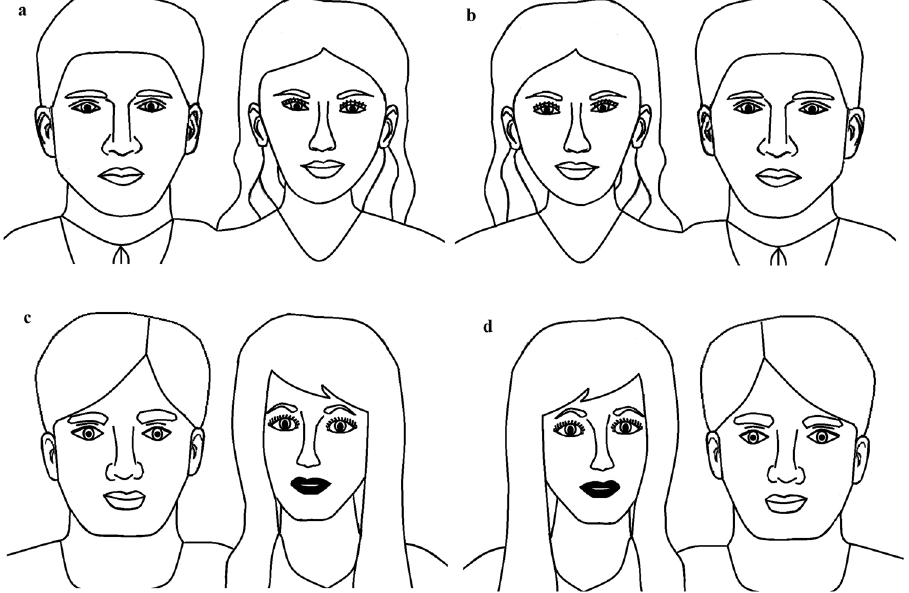
Figure 1. Figures used in the Tracing and Copying Conditions. The participants either traced or copied ( a ) and ( d ) or ( b ) and ( c